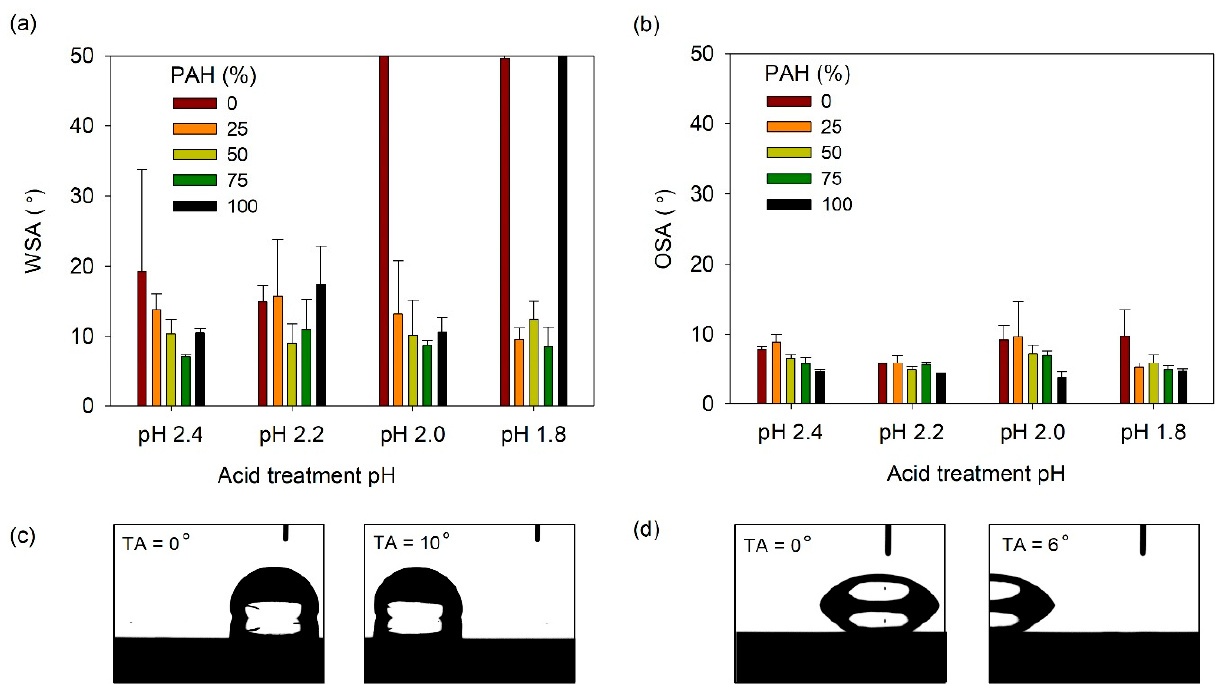
Figure 9. ( a ) WSA and ( b ) OSA of lubricant-infused LbL films with various PAH ratios and acid treatment pH values. A WSA of 50 ◦ denotes that the water droplet did not slide until the sliding angle increased to 50 ◦ . Optical micrographs showing the ( c ) water and ( d ) oil droplet sliding as the tilt angle (TA) increases. The lubricant-infused films of ( c ) pH 2.2, 25% PAH and ( d ) pH 2.2, PAH 50% were used.